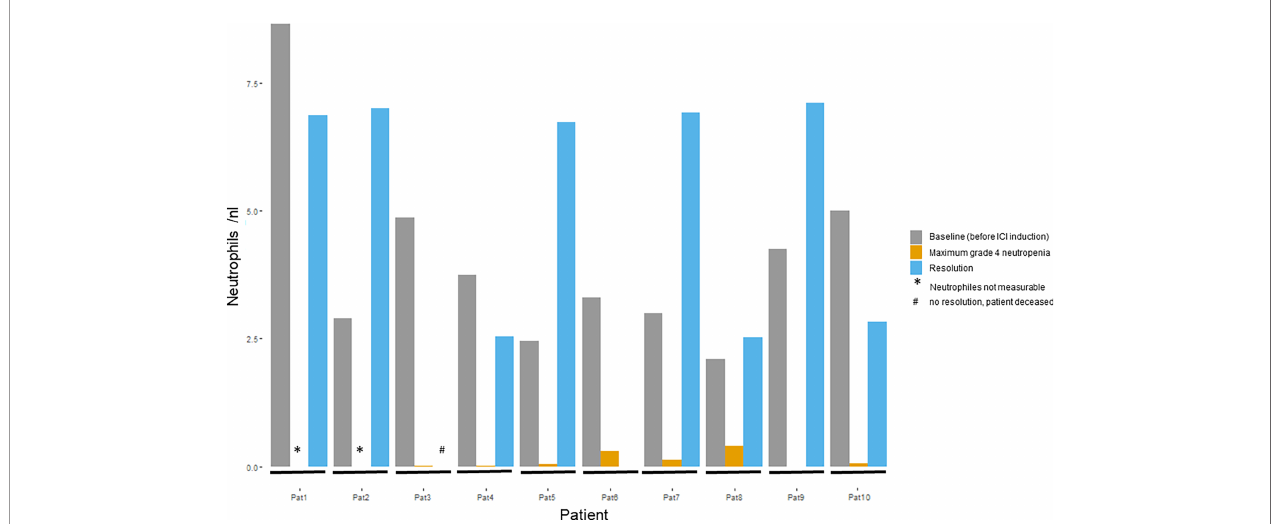
FIGURE 2 | Course of neutrophil granulocytes in patients with grade 4 irNeutropenia (n=10). Figure shows neutrophil values in nl at baseline (before ICI induction), for maximum grade 4 neutropenia, and, if it occurred, after resolution of neutropenia. ICI, immune checkpoint inhibitors; nl, nanoliter.